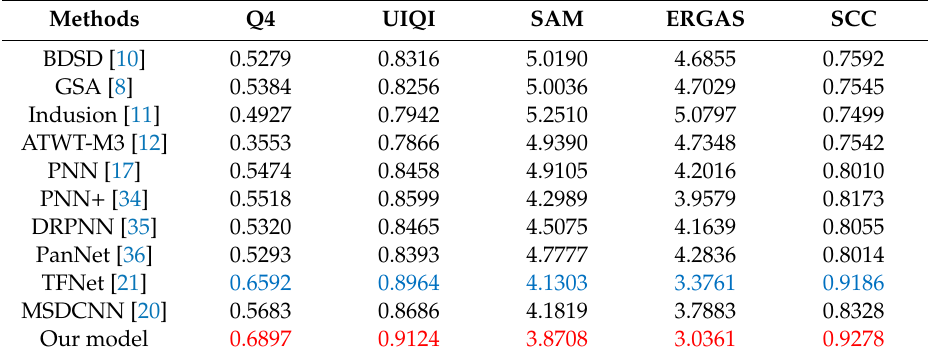
Table 7. Quantitative evaluation results of di ff erent methods on the IKONOS dataset. The best and the second best results are in red and blue, respectively.